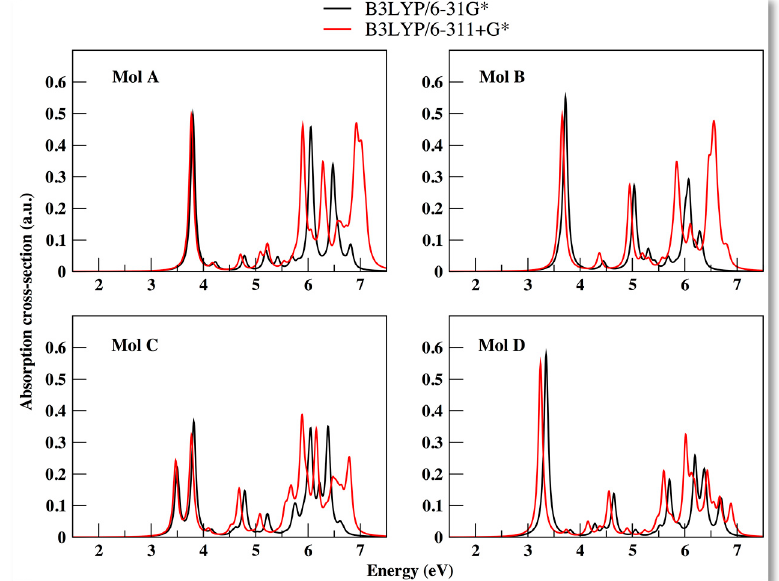
Figure 6. Calculated absorption spectra of coumarin derivatives using B3LYP XC functional with 6-31G* (black) and 6-311+G* (red) basis sets, respectively.